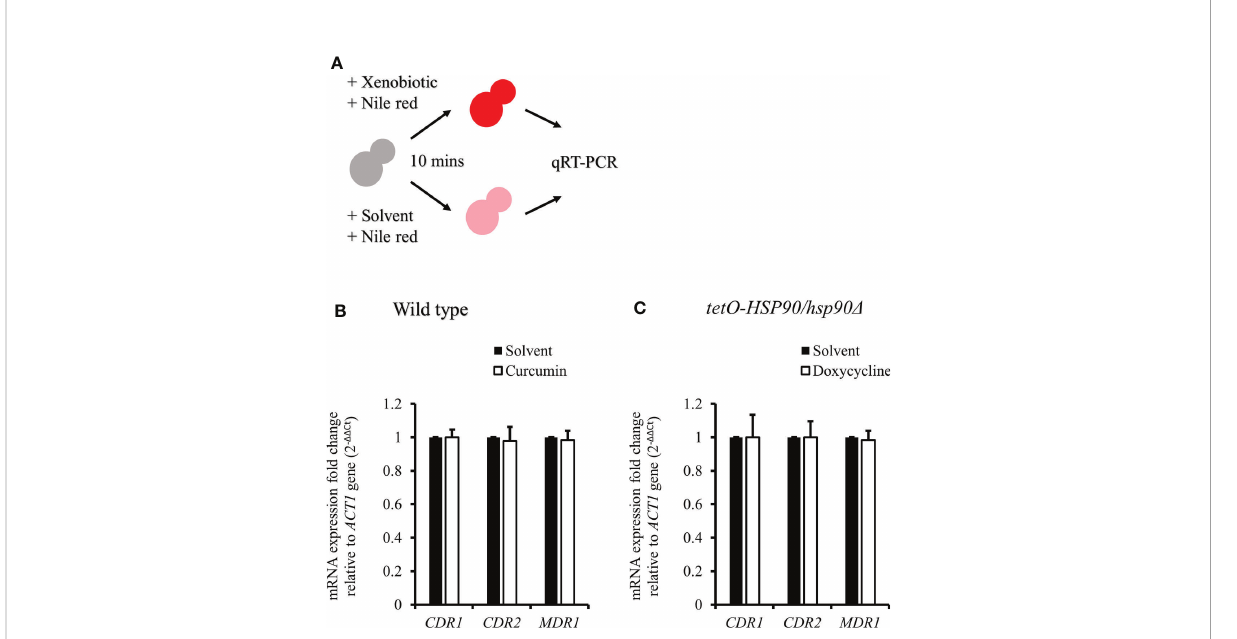
FIGURE 10 CDR1 , CDR2 , and MDR1 gene expressions in C. albicans after treatment with xenobiotics and Nile red for 10 min. (A) Diagram showing the qRT-PCR experiment. (B, C) The mRNA amounts of CDR1 , CDR2 , and MDR1 were determined by qRT-PCR in wildtype and tetO-HSP90/hsp90 D